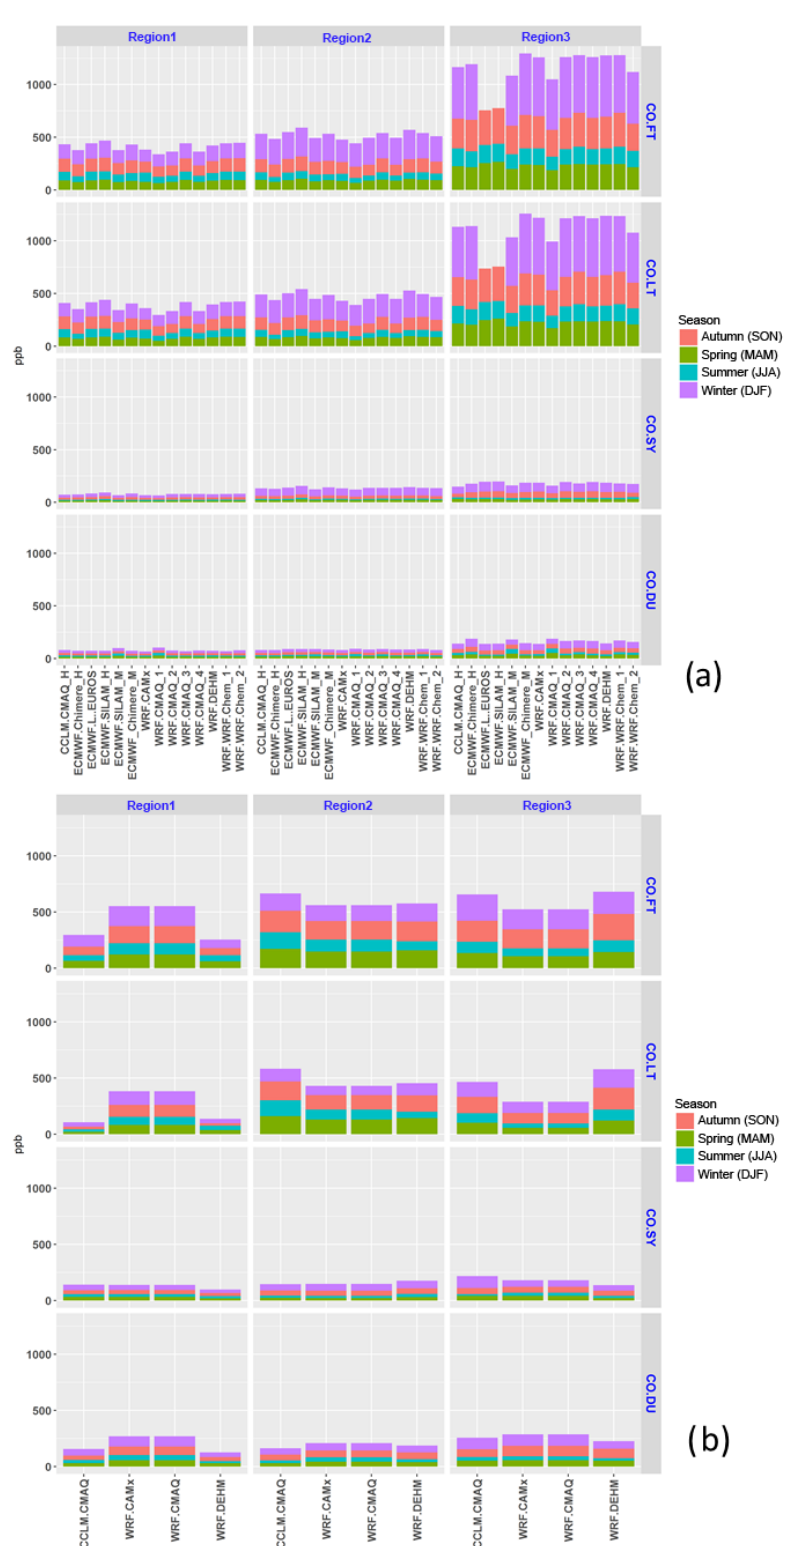
Figure 9. RMSE (ppb) for CO by spectral component and season (panel a for Europe and b for North America). FT is the full (unfiltered) time series, LT, SY, and DU are the long term, synoptic, and diurnal components, respectively.